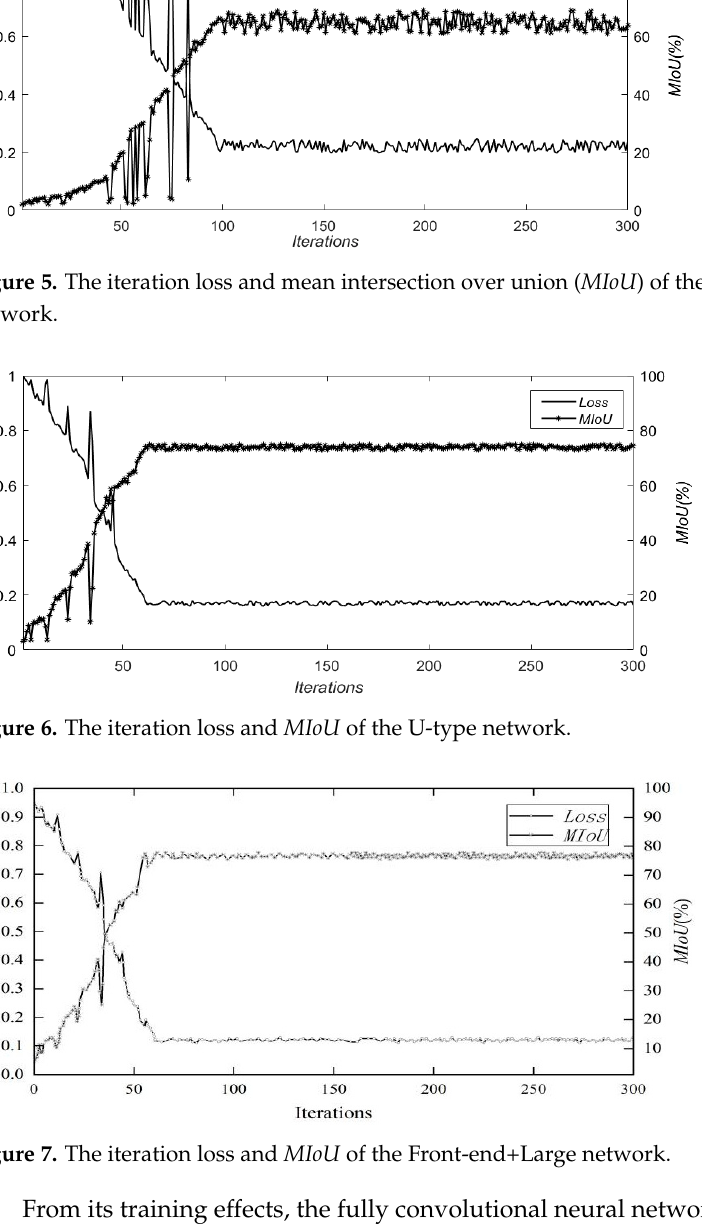
Figure 8. The iteration loss and MIoU of the deep residual U-type network. Table 2. Semantic segmentation results of different network models. Category